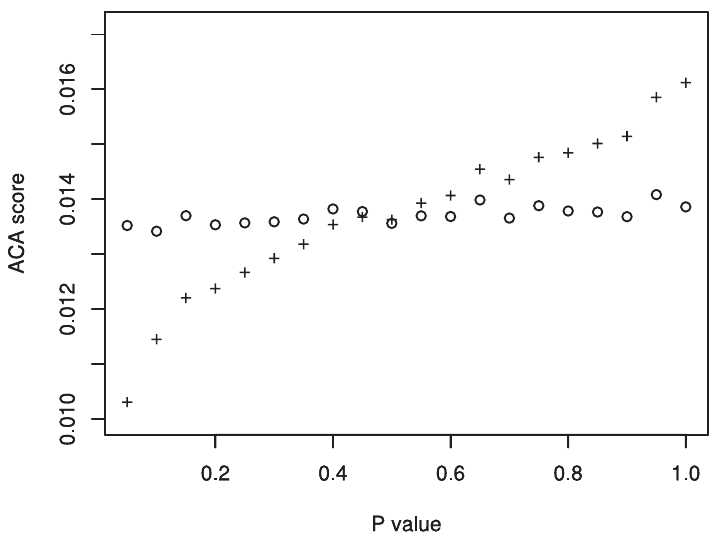
Figure 3. The difference between the true ACA scores and the randomized ACA scores. The difference between the randomized ACA score (hollow circles) and true ACA scores (plus sign) is displayed for all p-values. The true ACA score was deemed significantly different to the randomized ACA score if the p-value , =0.05.